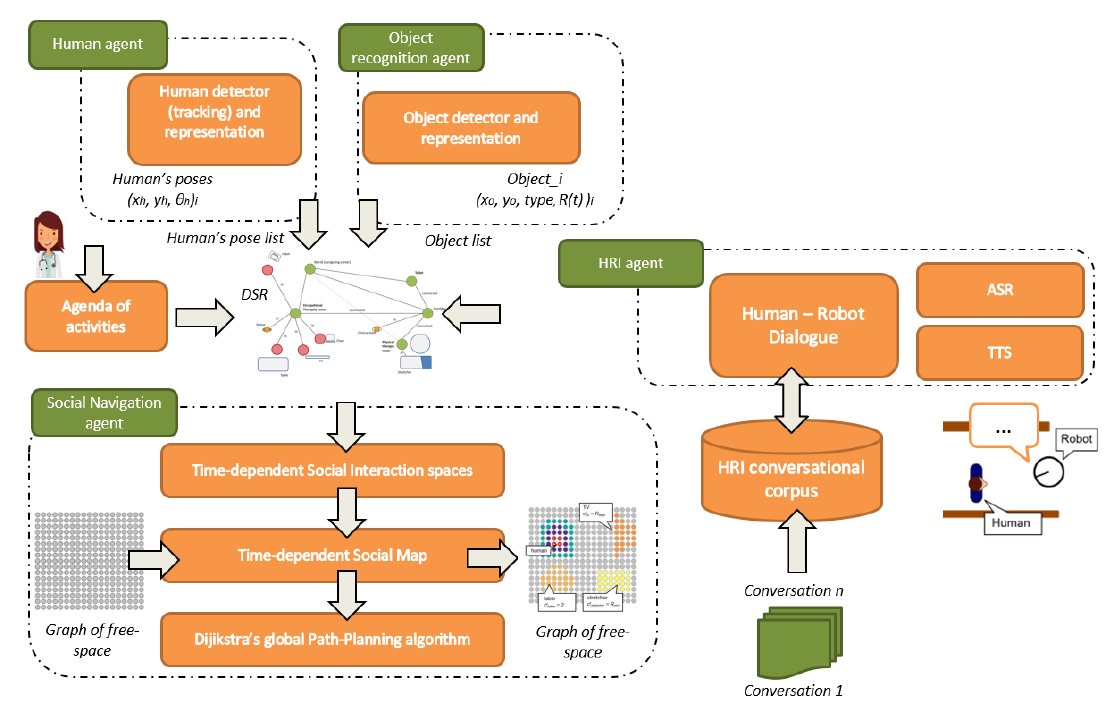
Figure 11. Overview of the social navigation framework within the